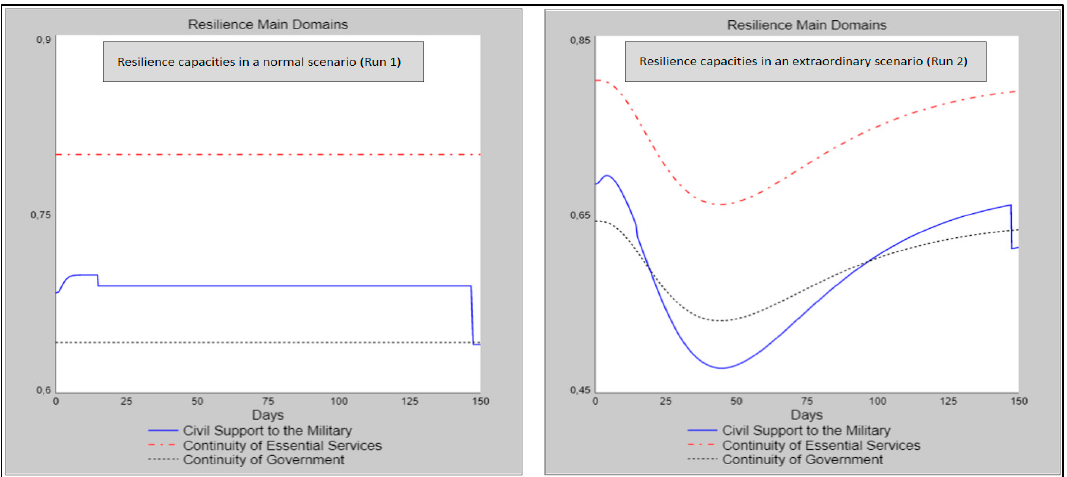
Figure 9. Sample output graph of resilience main domains for baseline (normal) and extraordinary scenarios.